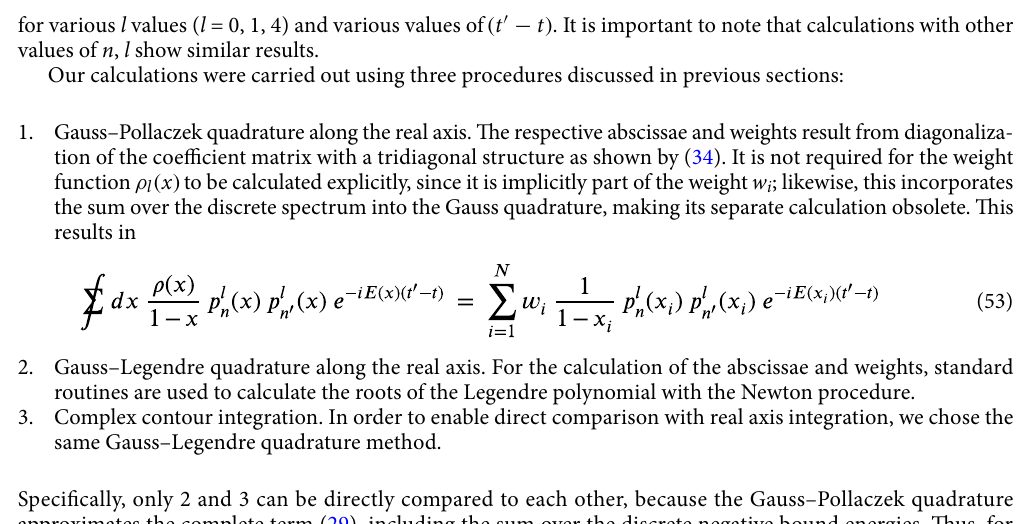
Table 2. Bound states sum. Computation of the sum over the discrete spectrum n max 2 π i f l n b = 1 (cid:31) n b = l + (cid:31) n b (cid:31) 0.41 , t 1 . Column 1: upper summation bound, column 2: values achieved using direct summation, ′ − t = = column 5: values achieved using extrapolation Aitken–Neville (51), column 3,4: parameters used in extrapolation (50),